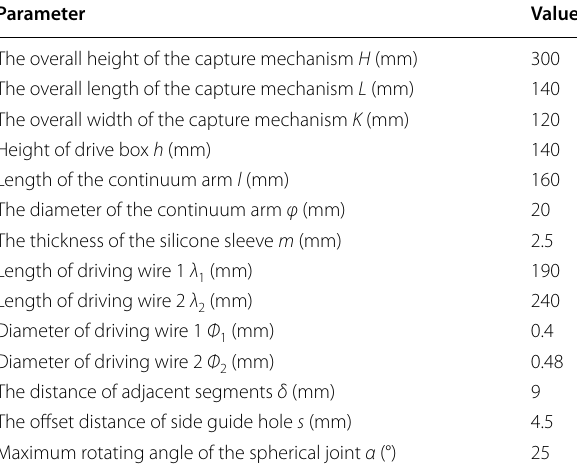
Table 1 Parameters of the capture